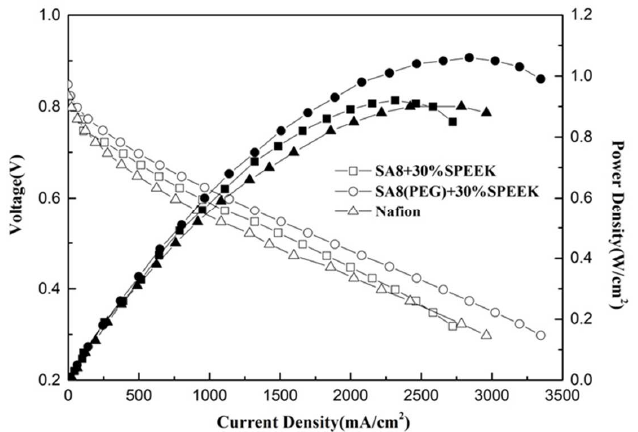
Figure 24. Fuel cell component performance diagram of SA8 blended with PEG and 30% sPEEK.